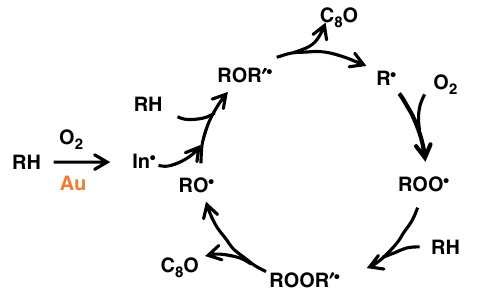
Figure 6 | Proposed function of Au in cyclooctene epoxidation with O 2 . Proposed catalytic function of Au atomic clusters in the autooxidation cycle for the formation of cyclooctene epoxide (C 8 O). R ¼ c-C 8 H 13 , R’ ¼ c-C 8 H 14 , and In (cid:4) is free radical initiator. Note that Au functions to generate free radical initiators and is not necessary in the C 8 O formation